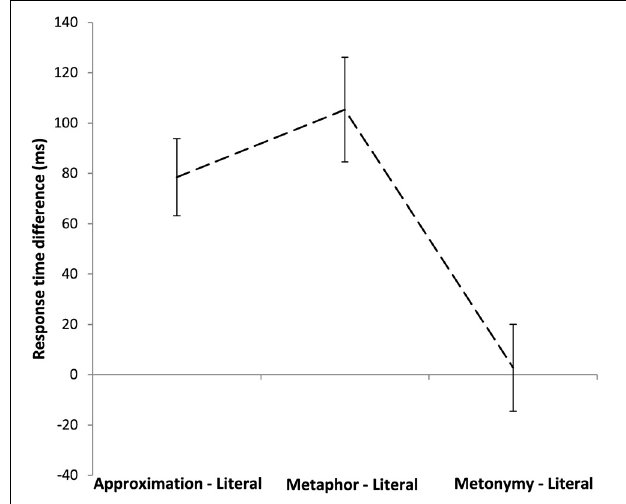
FIGURE 4 | Reaction times differences (pragmatic minus literal) for the Approximation set, the Metaphor set, and the Metonymy set. Error bars correspond to the standard error of the difference for each